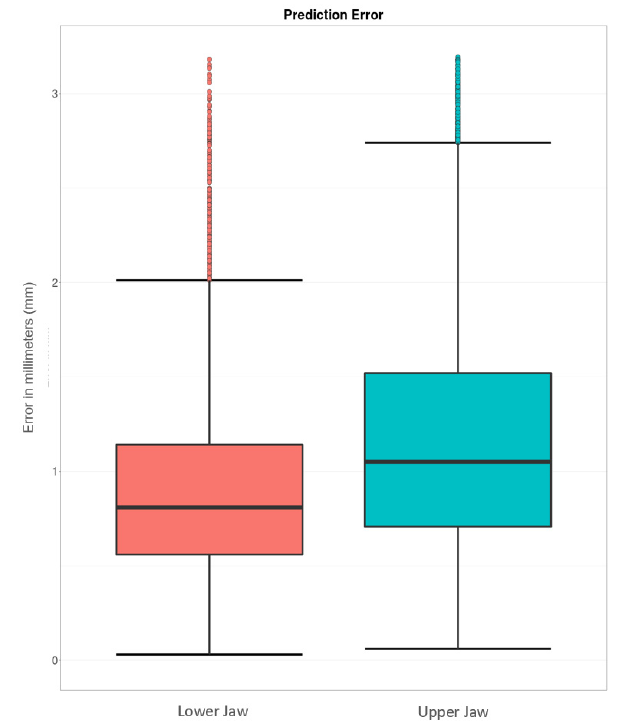
Figure 3. Boxplot showing the error distribution of the reconstruction of the MG-BL on all tested individuals using the developed SSM.